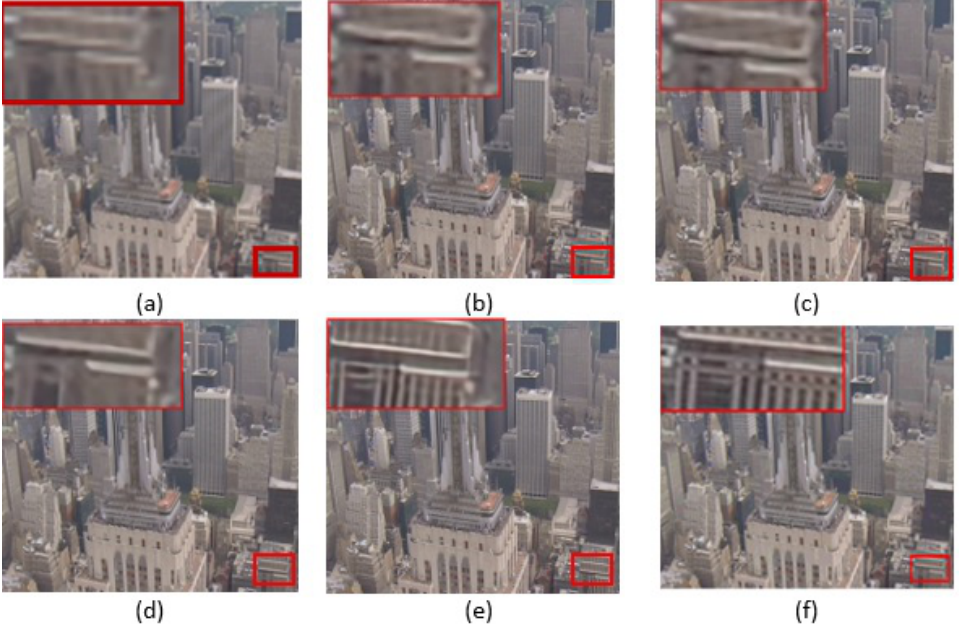
Figure 4. Qualitative comparison between VSR results obtained by ( a ) Bicubic, ( b ) VSRNET [24], ( c ) SRCNN [16], ( d ) VESPCN [27], ( e ) Proposed and ( f ) Ground-Truth on “ city ” from Vid4 with scaling factor of x4.